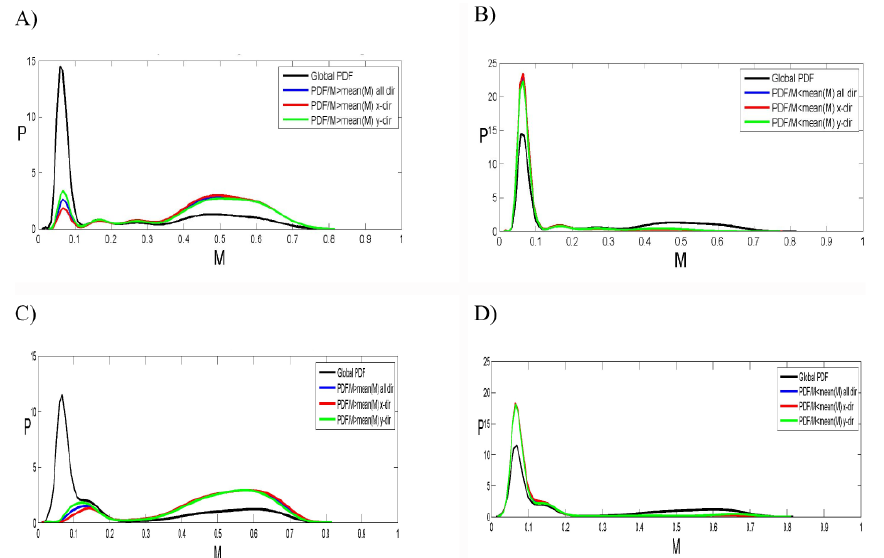
Fig. 6. Global and conditioned PDF analysis of the Niger patterns. Panels (A/B) : natural, and (C/D) : simulated vegetation; panels (A/C) : density higher than global average, and (B/D) : density lower than global average. (A) PDFs of vegetation density for the natural pattern shown in Fig. 4a (as digitized in Fig. 4d): global PDF (black line) and PDFs of vegetation density conditioned on having a neighbor pixel with vegetation density higher than the global average for all directions (blue line), x-direction (red line) and y-direction (green line). (B) PDFs of vegetation density for the natural pattern shown in Fig. 4a (as digitized in Fig. 4d): global PDF (black line) and PDFs of vegetation density conditioned on having a neighbor pixel with vegetation density lower than the global average for all directions (blue line), x-direction (red line) and y-direction (green line). (C) PDFs of vegetation density for the simulated pattern shown in Fig. 4g: global PDF (black line) and PDFs of vegetation density conditioned on having a neighbor pixel with vegetation density higher than the global average for all directions (blue line), x-direction (red line) and y-direction (green line). (D) PDFs of vegetation density for the simulated pattern shown in Fig. 4g: global PDF (black line) and PDFs of vegetation density conditioned on having a neighbor pixel with vegetation density lower than the global average for all directions (blue line), x-direction (red line) and y-direction (green line).